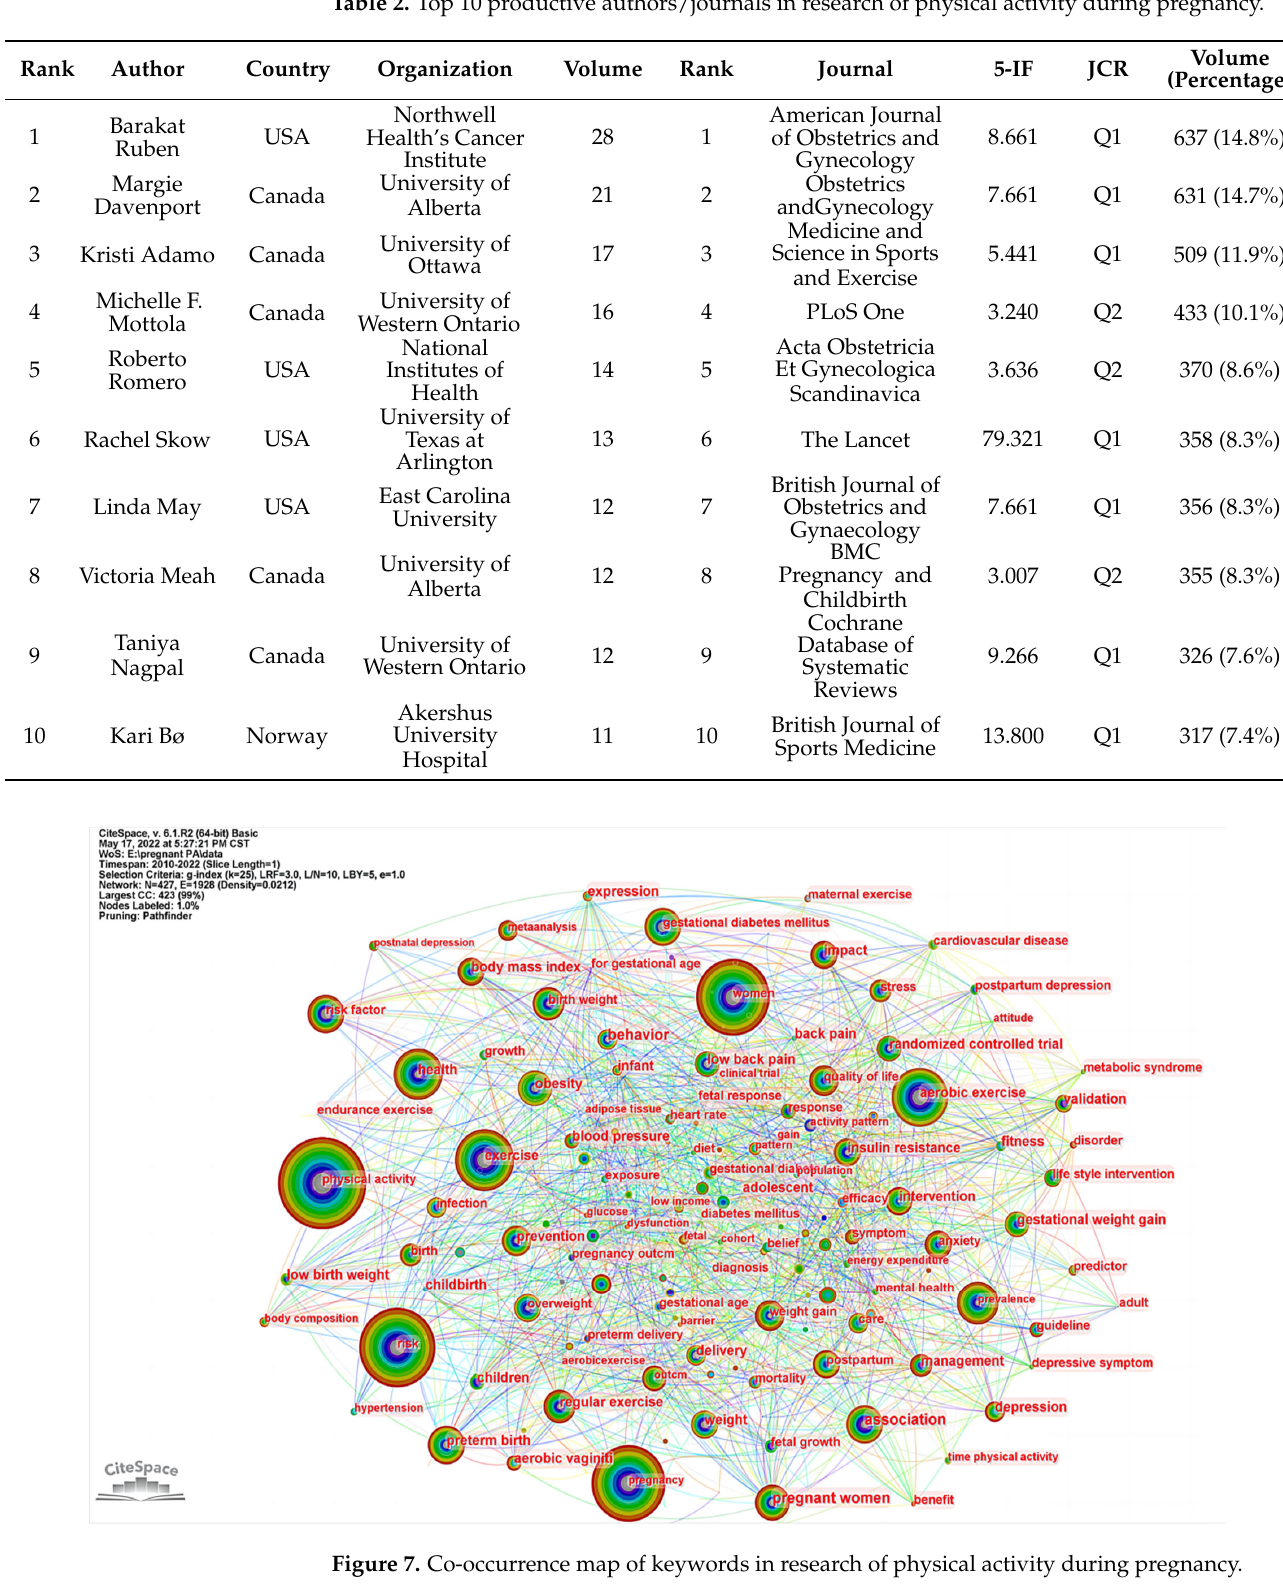
Table 2. Top 10 productive authors/journals in research of physical activity during pregnancy.